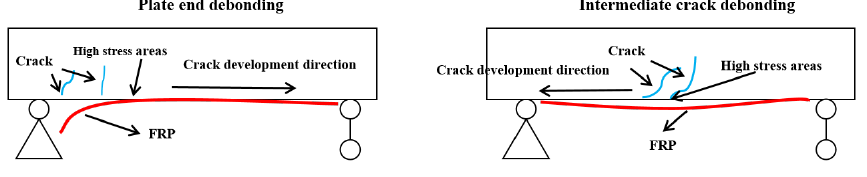
Figure 1. Debonding modes.